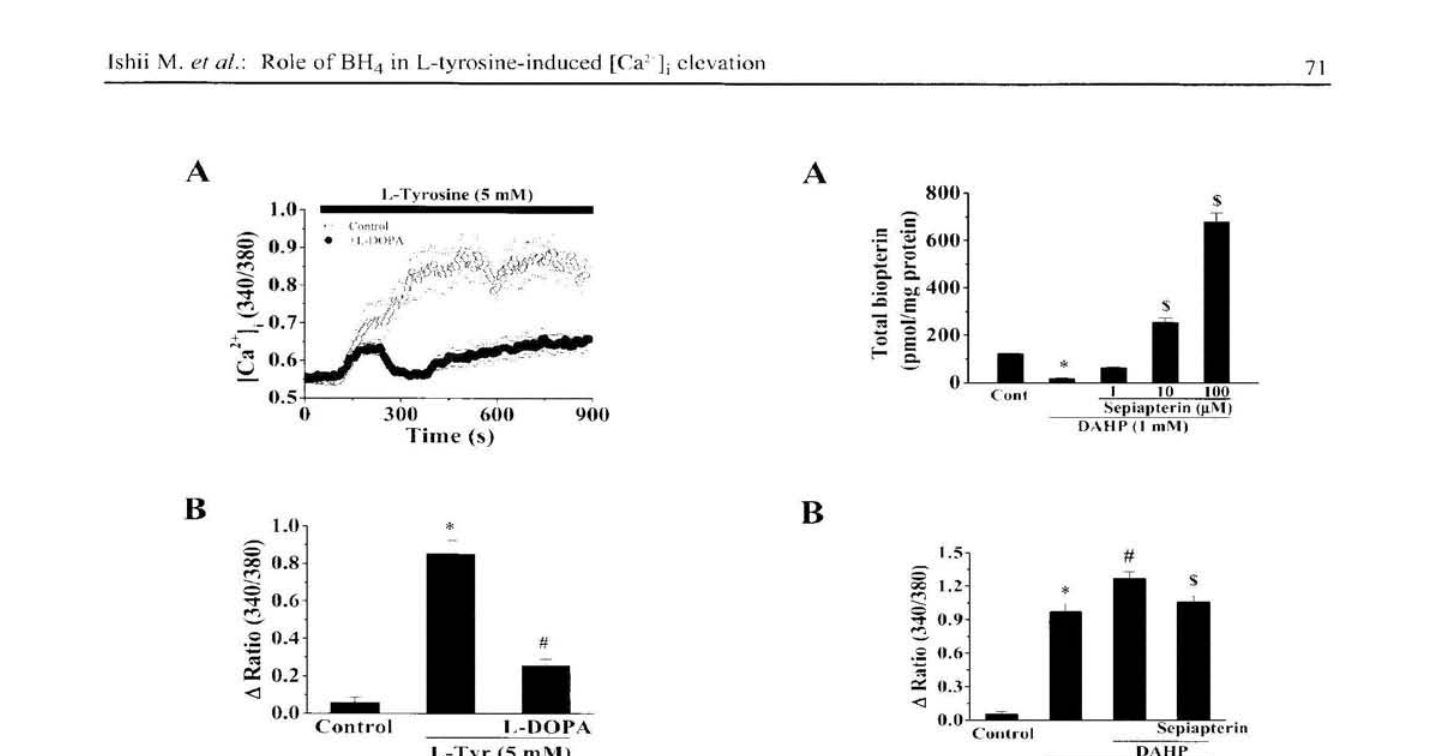
Figure 2 Effect of L-DOPA on L-tyrosine-induced [Ca 2 ]j elevation in HIT-T15 cells. In A, cells were treated with L-tyrosine (5 mM) in the presence of L- DOPA (5 mM).